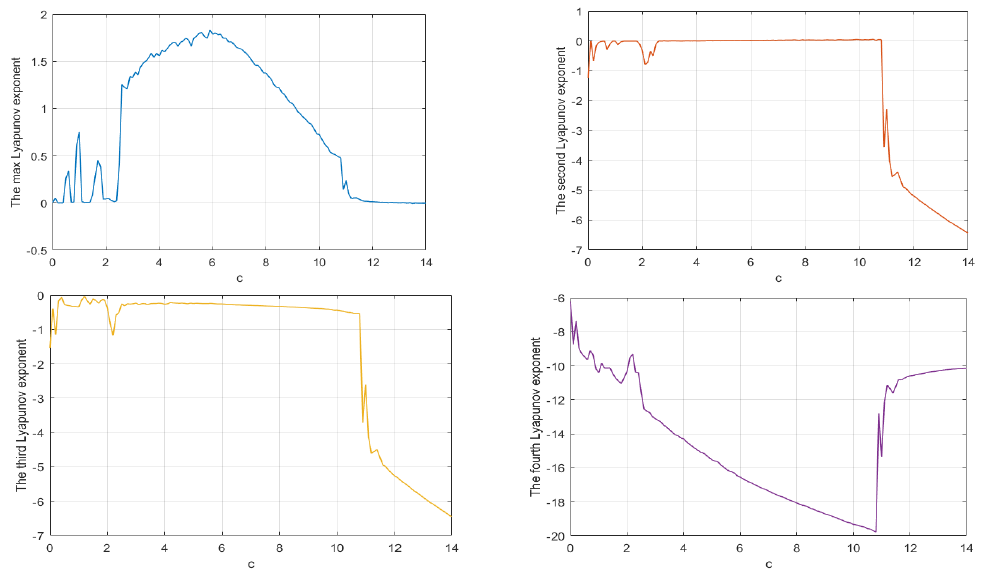
Figure 14. Spectrum of Lyapunov exponents for c ∈ [ 0,14 ] .